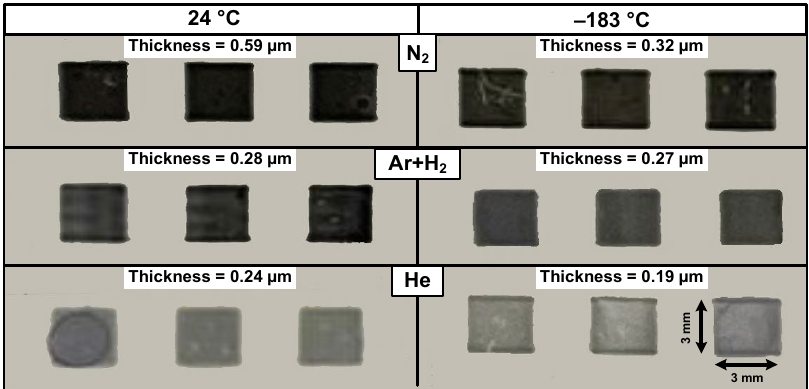
Figure 7. Photographs of SERS structures in the form of square pads 3 mm × 3 mm, formed with different atmospheres and temperatures of nanoparticle synthesis.